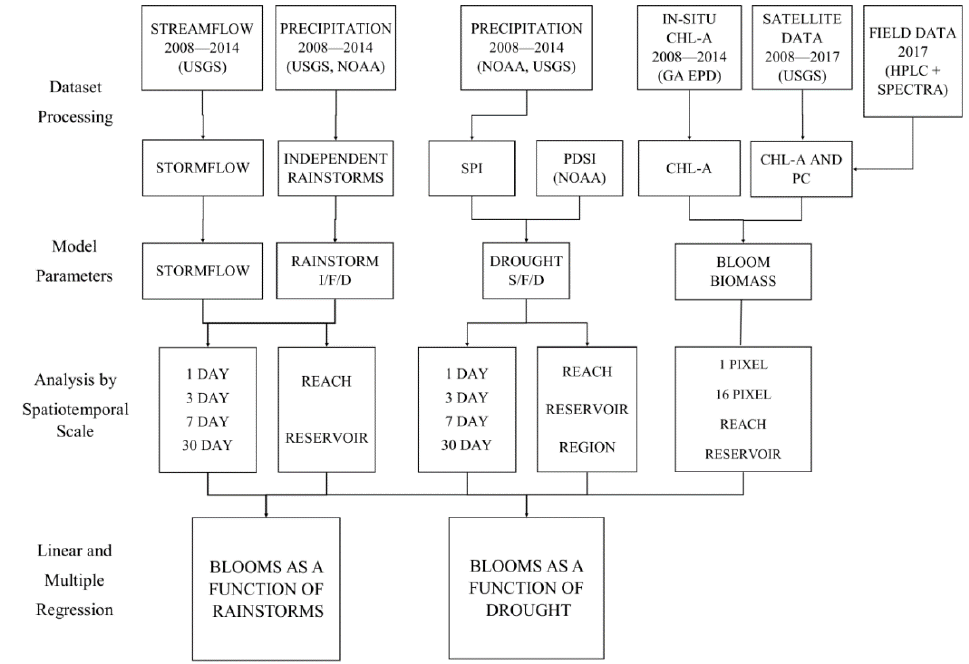
Figure 3. The overall strategy for the study progresses from dataset compilation and processing to comparison of all model parameters with algal blooms across a variety of spatial and temporal scales. Rainstorm I/F/D and Drought S/F/D refer to intensity, frequency, duration, and severity, frequency, duration, respectively.